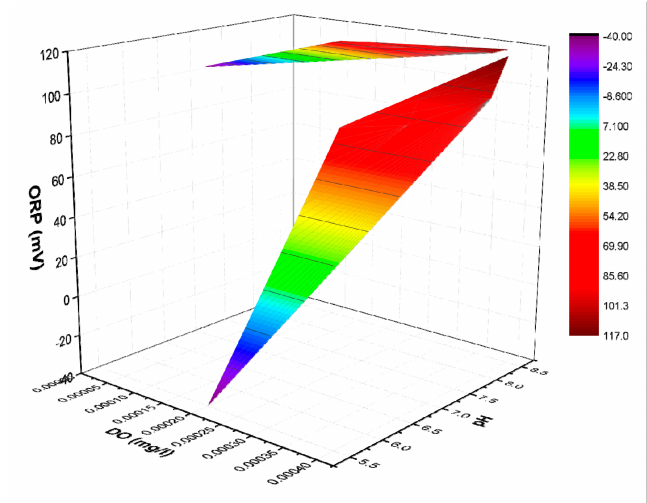
Figure 9. The intersection of ORP, DO, and pH indicating the best conditions for nitrifying